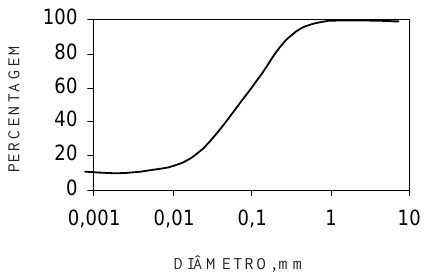
Figura 1. Representação de uma curva de distribuição textural acumulada típica do